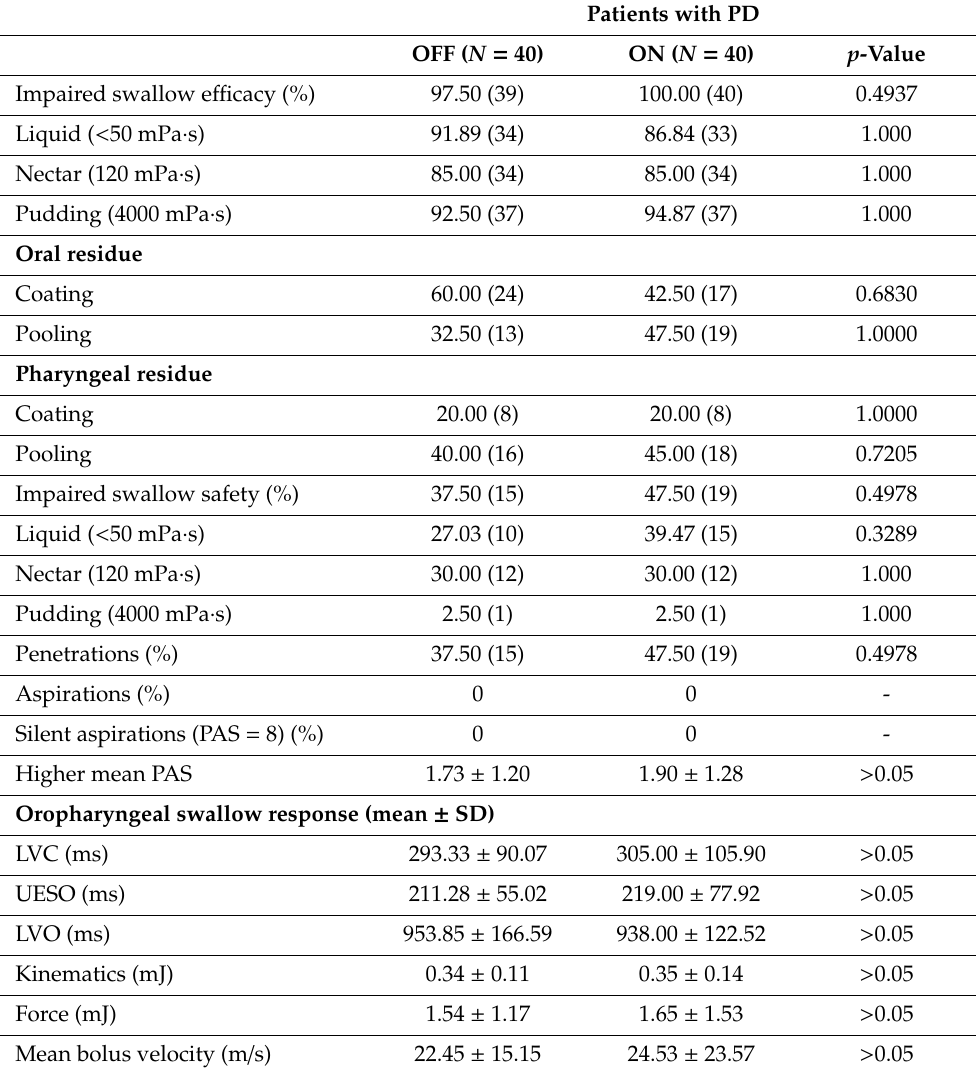
Table 3. Videofluoroscopy (VFS) signs of impaired swallow safety and e ffi cacy and oropharyngeal swallow response for patients with Parkinson’s disease (PD) in dopaminergic OFF and ON